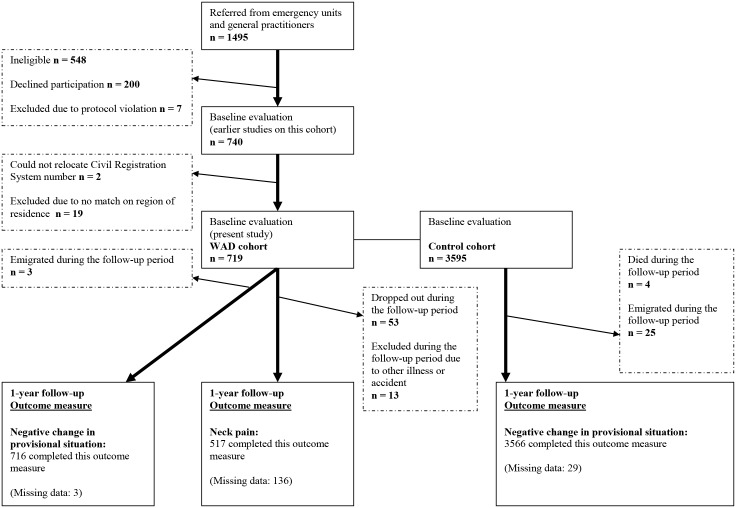
Flow chart of inclusion, exclusion and outcome of whiplash and control cohorts.